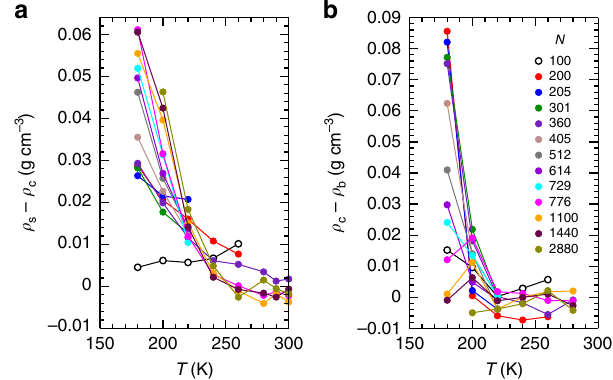
Fig. 6 Emergence of density differences within nanodroplets with decreasing temperature. a ρ s − ρ c versus T , and b ρ c − ρ b versus T , for nanodroplets of various N , as indicated in the